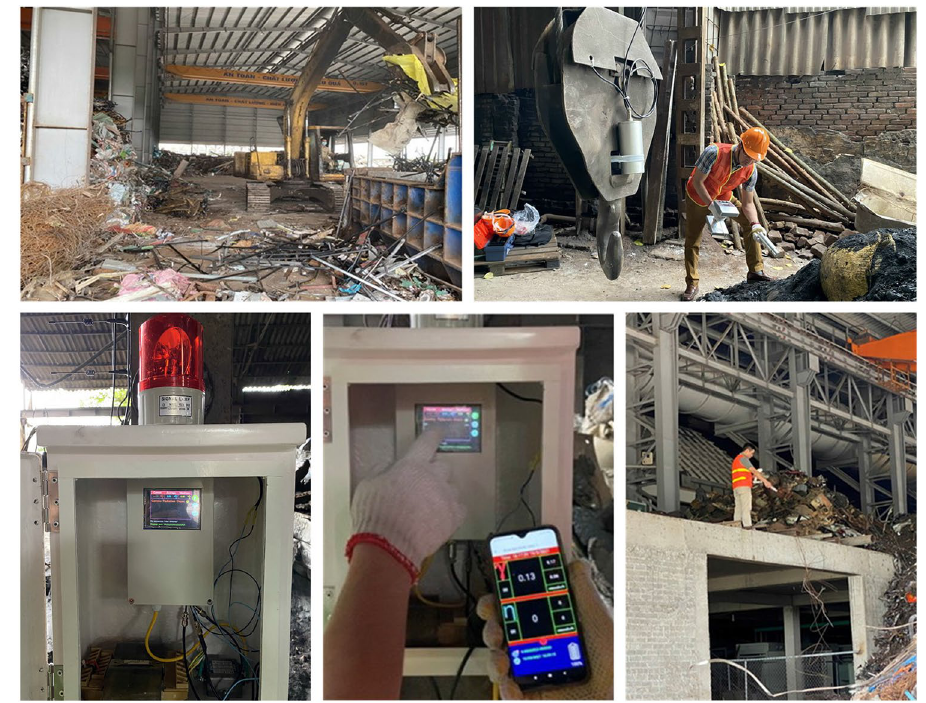
Figure 16. Testing the radioactive detection system in a scrap metal recycling facility.